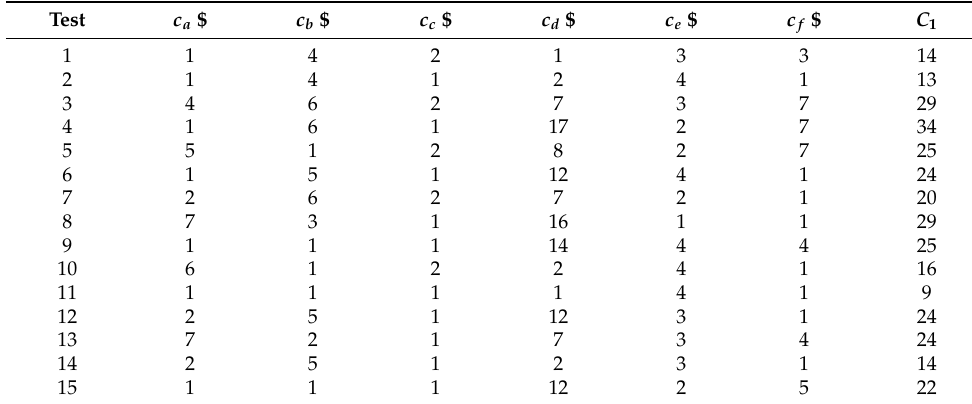
Table A3. Costs for standard extraction method ( i = 1).